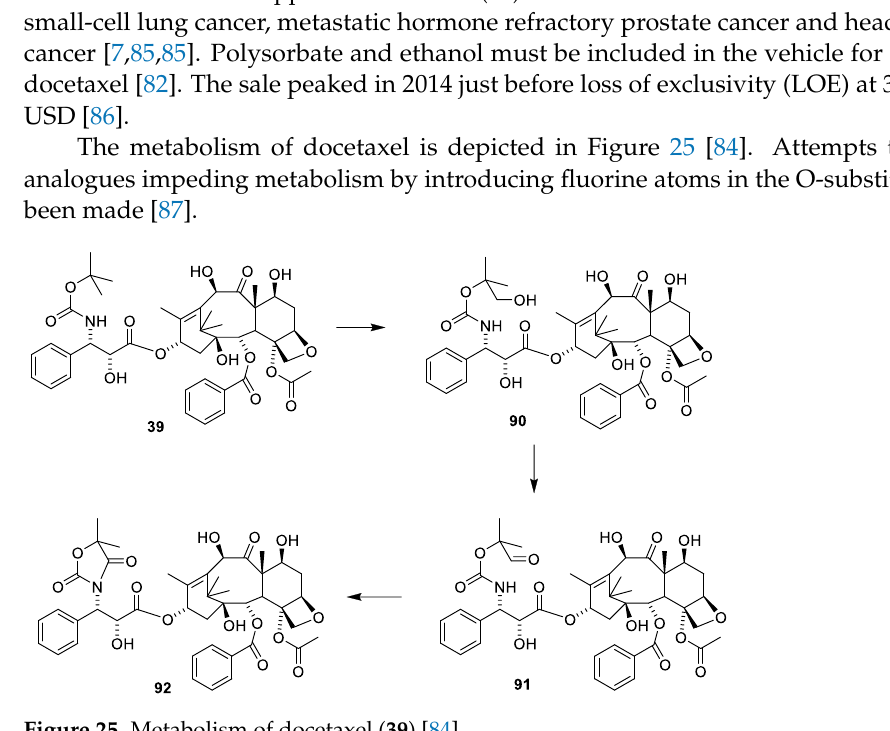
Figure 25. Metabolism of docetaxel ( 39 ) [84]